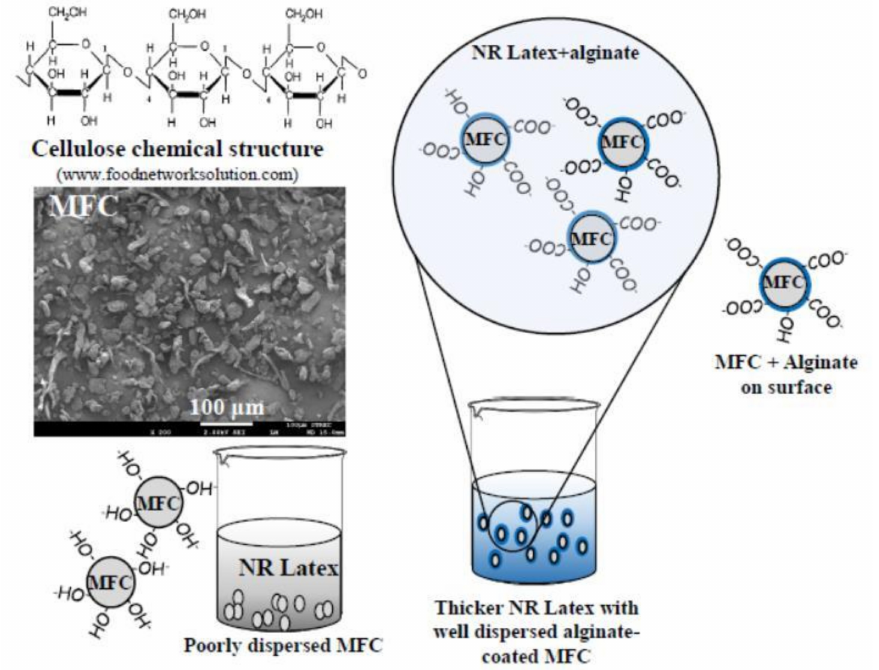
Figure 1. Schematic illustration of preparation of MFC–NR composites by latex compounding in the presence of